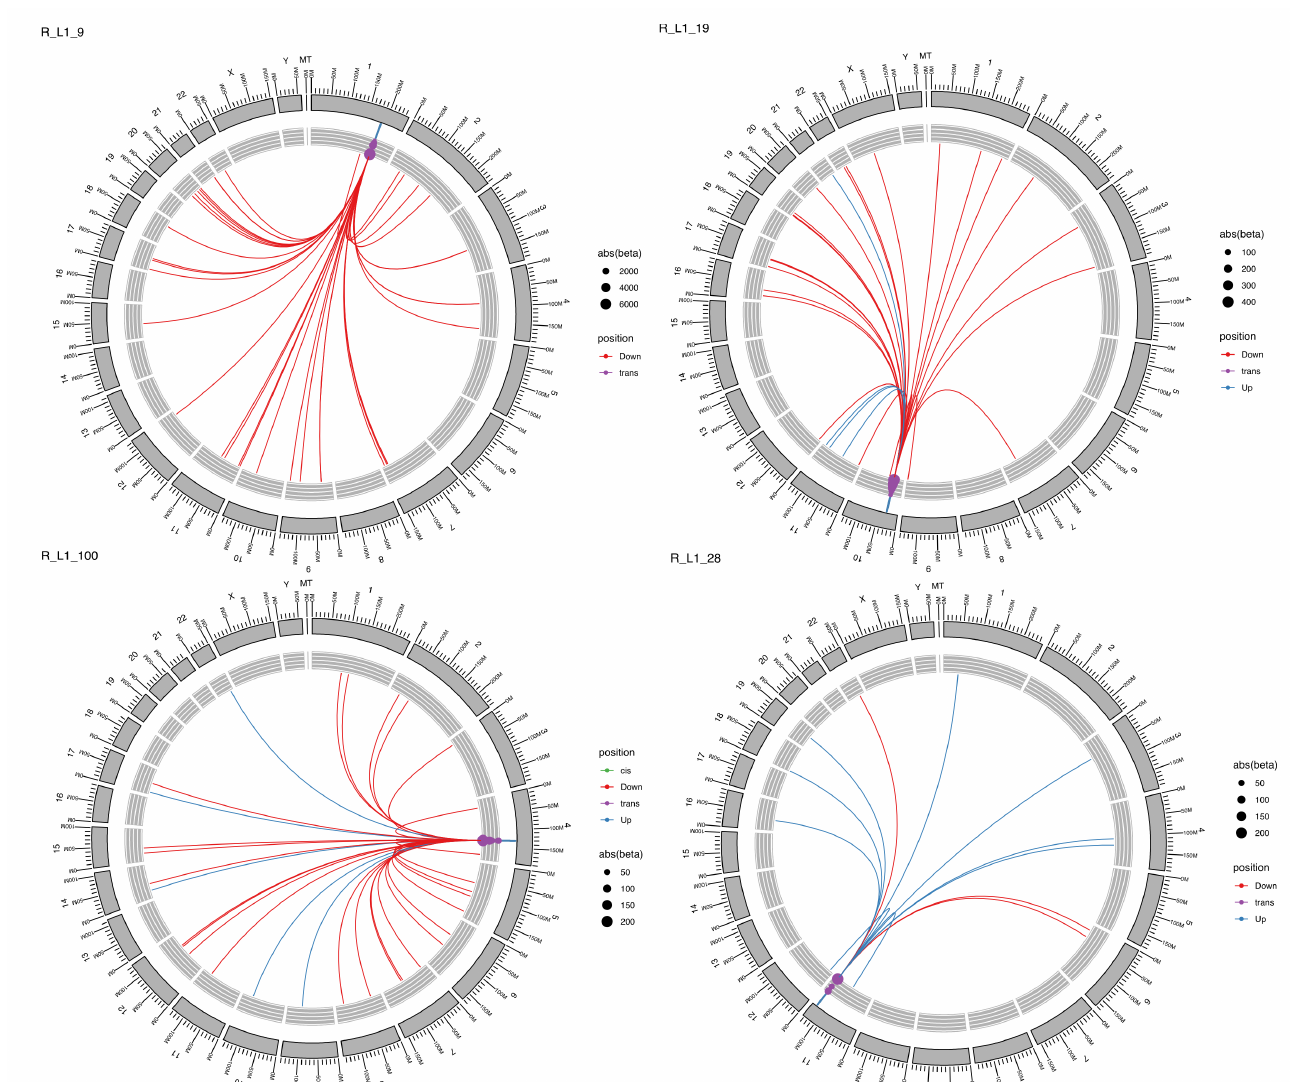
Figure 5. Circos plots showing the targets and effects for four different L1s. Blue line is for up-regulation; red line is for down-regulation of the gene. Dot size is beta value; dot colour is trans or cis